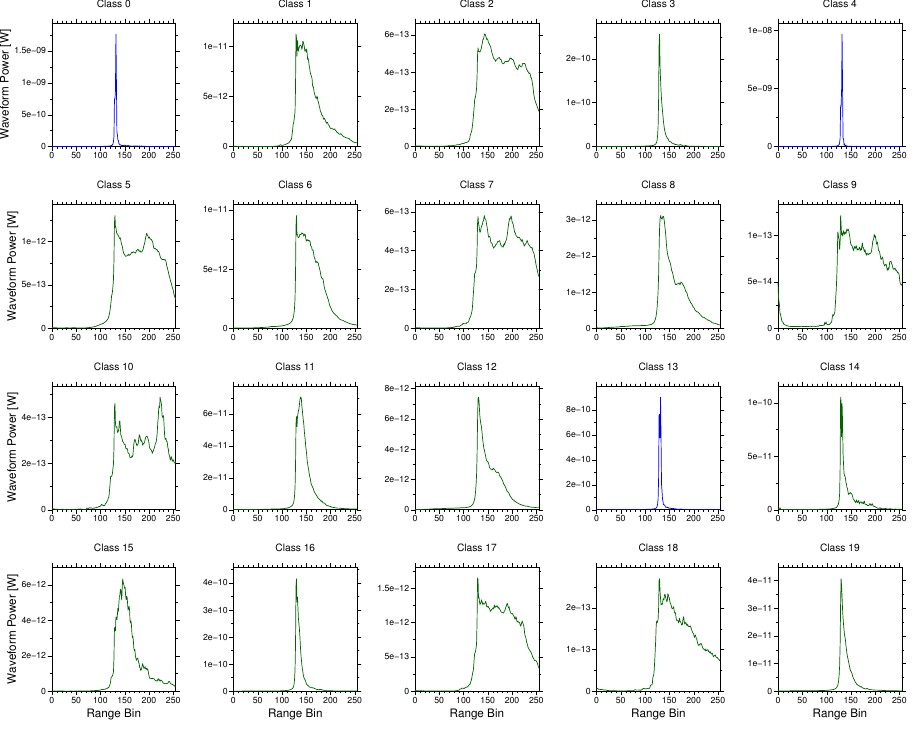
Figure A1. Upstream region mean waveforms. Water classes: 0, 4, 13.